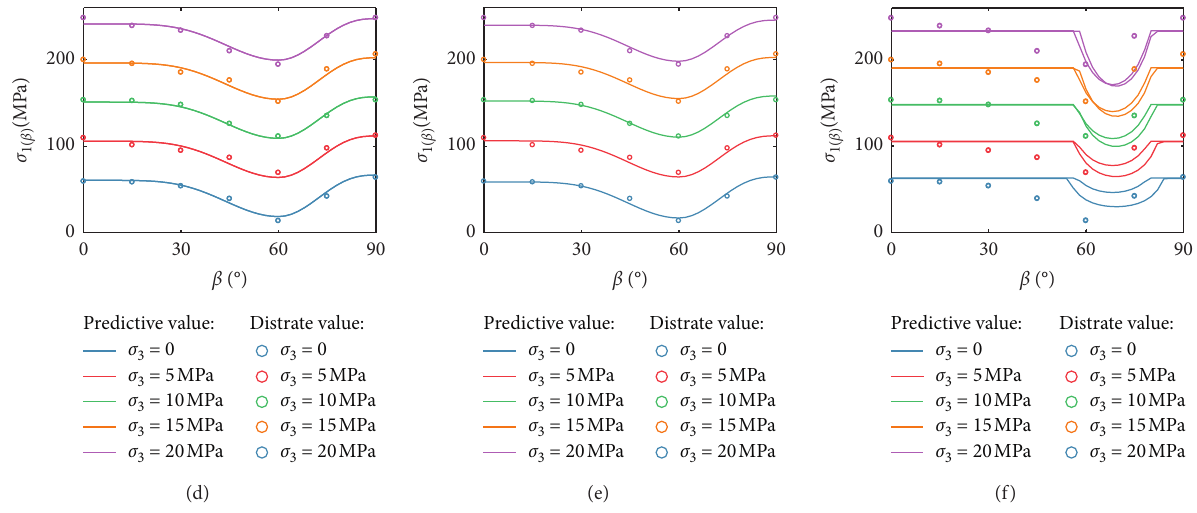
Figure 6: Predicted vs. experimental strength of sandstone (data from [62]). (a) Pariseau n � 1. (b) Pariseau n � 2. (c) Random starting value. (d) LEE. (e) NLEE. (f)